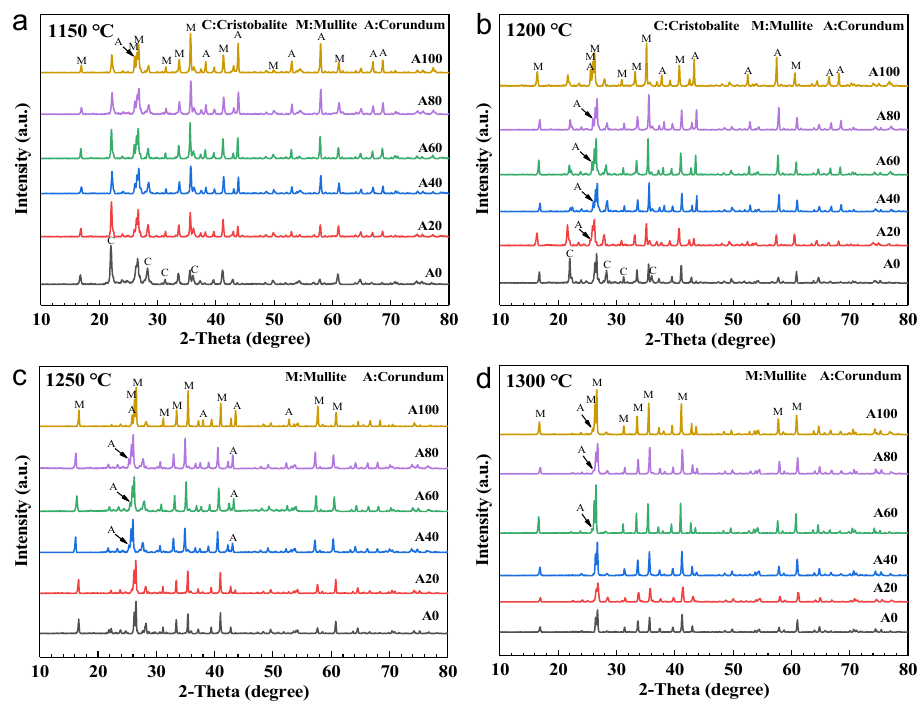
Figure 4. XRD patterns of fly ash supports with different bauxite contents sintering at 1150 °C ( a ), 1200 °C ( b ), 1250 °C ( c ) and 1300 °C ( d ).